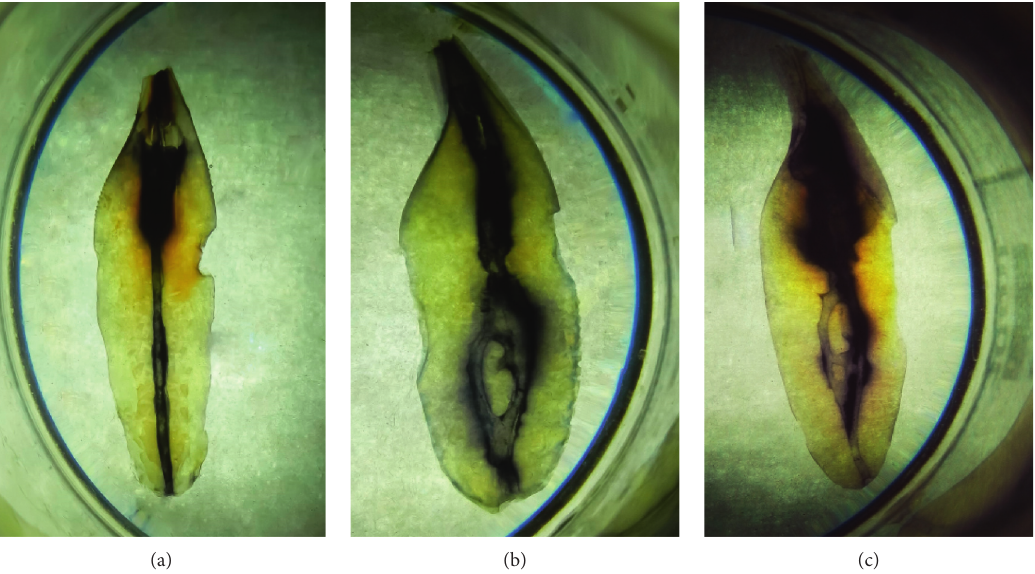
Figure 1: Vertucci’s type Ι , type ΙΙΙ , and 1-2-1-2-1.